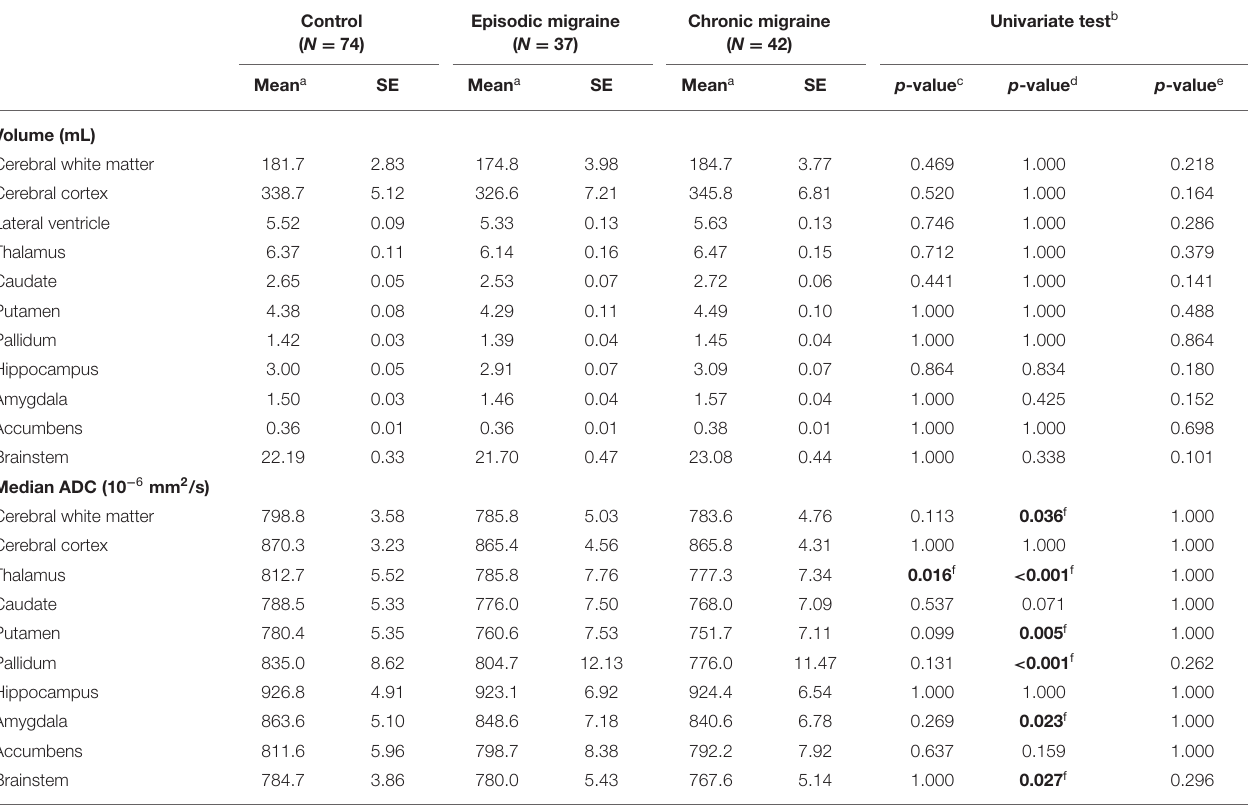
a Covariates appearing in the model are evaluated at the following values: age (years) at time of MRI = 21.71, sex (1 as female) = 0.73. b Based on the linearly independent pairwise comparisons among the estimated marginal means. c Episodic—Control. d